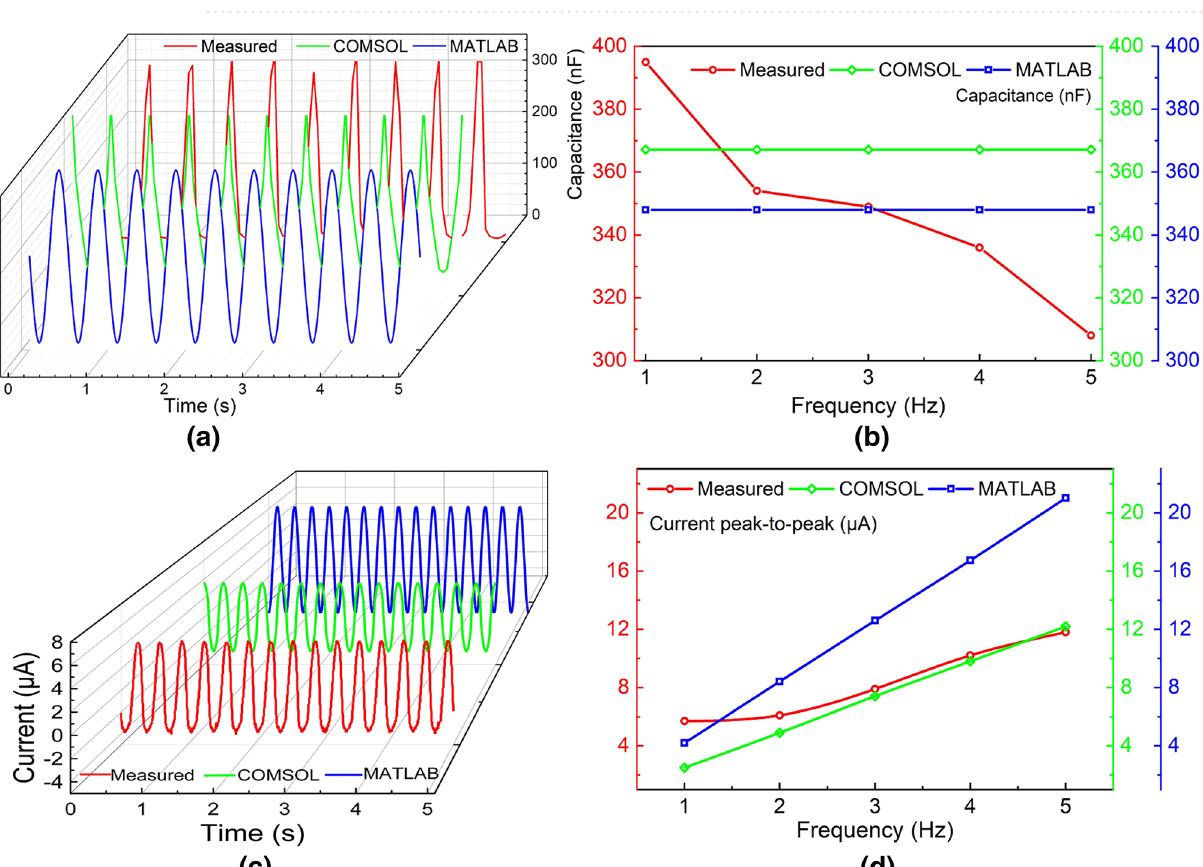
Figure 7. ( a ) Measured and modeled (COMSOL and MATLAB) representative capacitance over time at 2 Hz frequency of modulation for 38 µ m sample, ( b ) capacitance over the frequency of modulation, ( c ) measured and modeled (COMSOL and MATLAB) representative current over time at 2 Hz frequency of modulation for 38 µ m sample, ( d ) peak-to-peak current over the frequency of